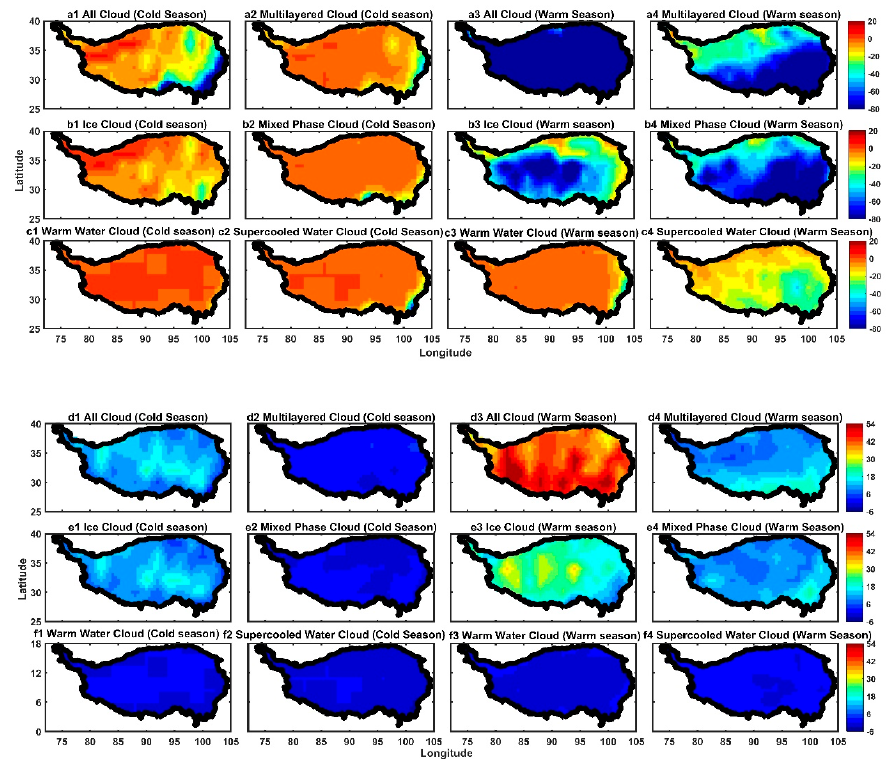
Figure 2. Four-year cloud radiative effect (CRE) (Wm − 2 ) of different cloud phases over the TP. ( a1 – c4 ) represent the top of the atmosphere (TOA); ( d1 – f4 ) represent the ATM. The spatial resolution is a 0.5° × 0.5° grid (The two columns on the left represent the cold season and the two columns on the right represent the warm season. Here, ice clouds, liquid clouds, and mixed-phase clouds refer to the case of the single-layer clouds).